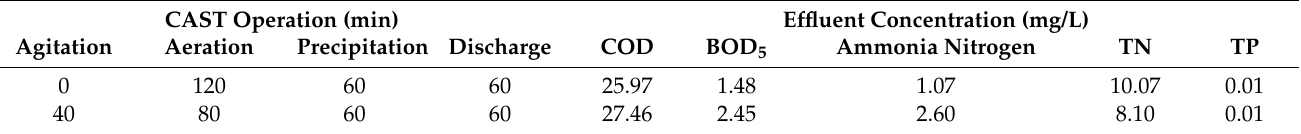
Table 3. The simulation results from different operation periods of the CAST